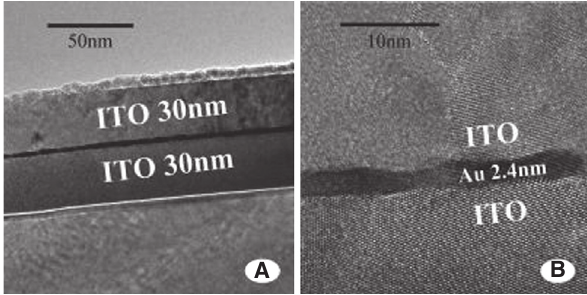
Figure 7: Low roughness 30-nm-thick ITO layers. Reproduced with permission from